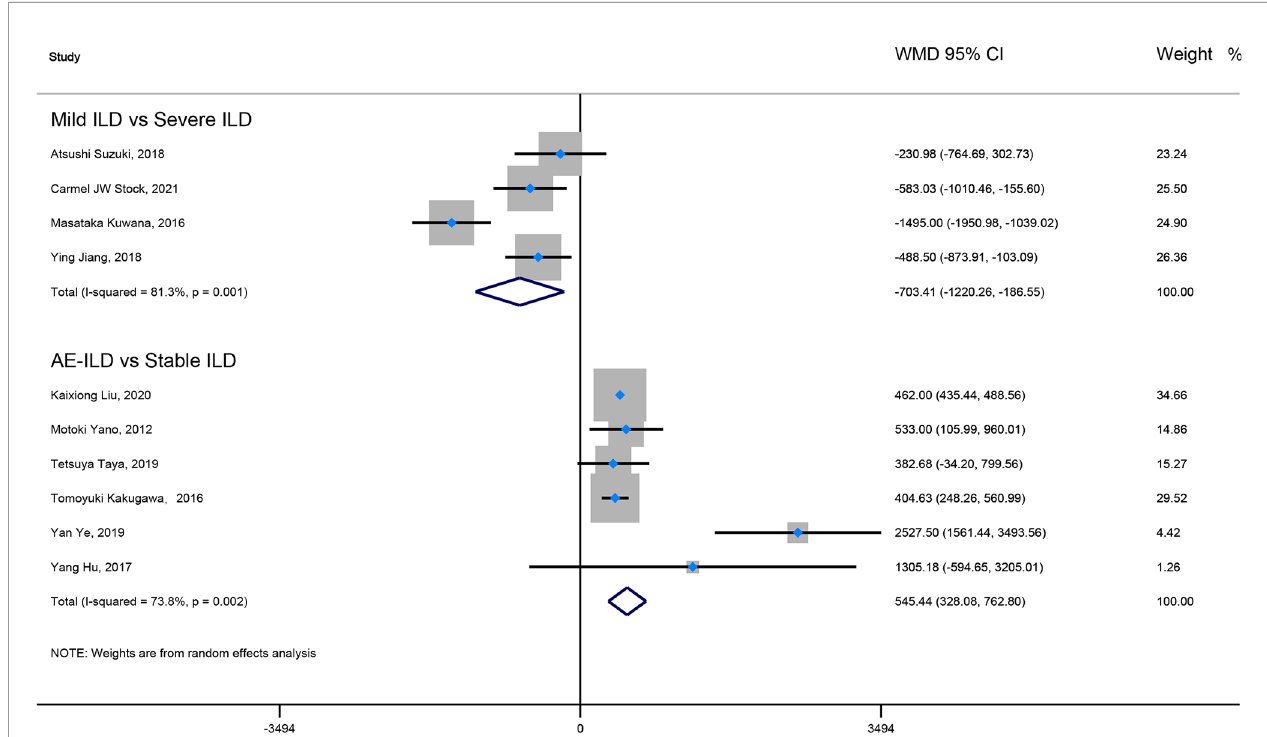
FIGURE 2 | The forest plot pooled the WMD (95%CI) of KL-6 level between mild ILD and severe ILD, between AE-ILD and stable